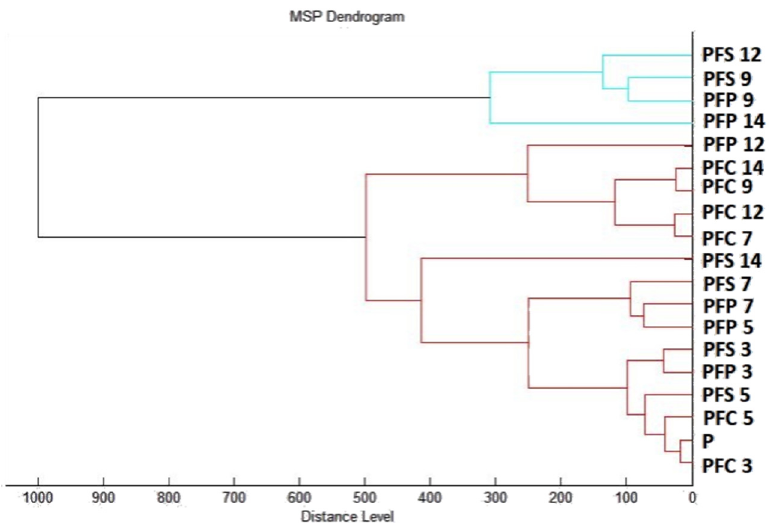
Figure 6. A dendrogram of P. fluorescens was generated using MSPs of the planktonic cells and the control. PF, P. fluorescens ; C, control; S, stainless steel; P, plastic; and only P, planktonic cells.